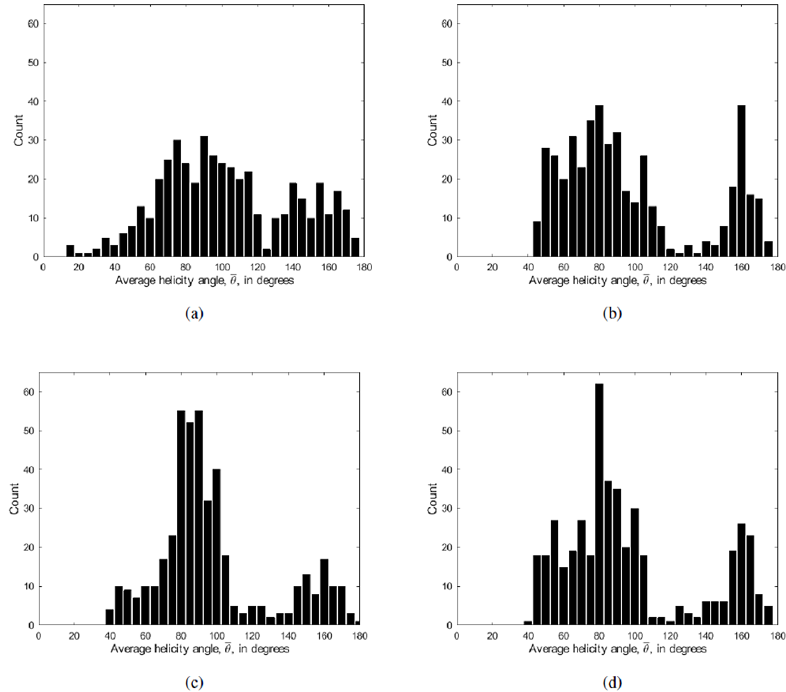
Figure 8. Bar charts of the average helicity angle, θ , in degrees, on the z = 0mm plane: (a) for an unexcited jet; (b) for an excited jet with St = 0.93; (c) for an excited jet with St = 1.86; and (d) for an excited jet with St =